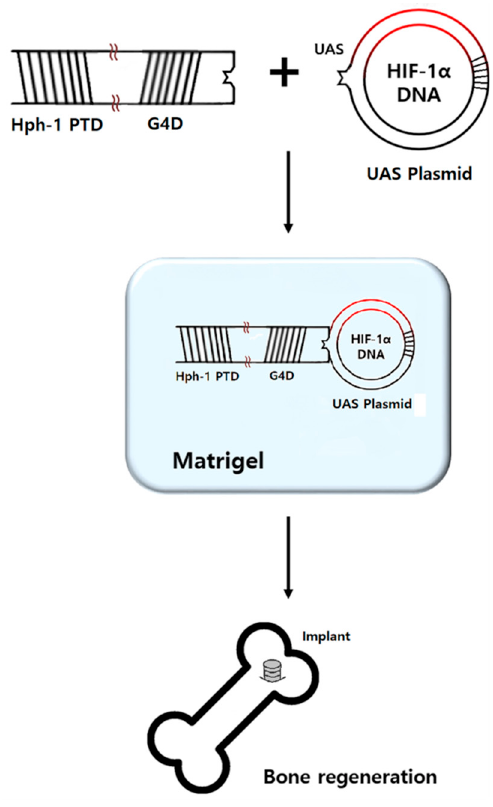
Figure 3. GAL4 DNA binding domain (G4D) was cloned into pRSETB plasmid expression